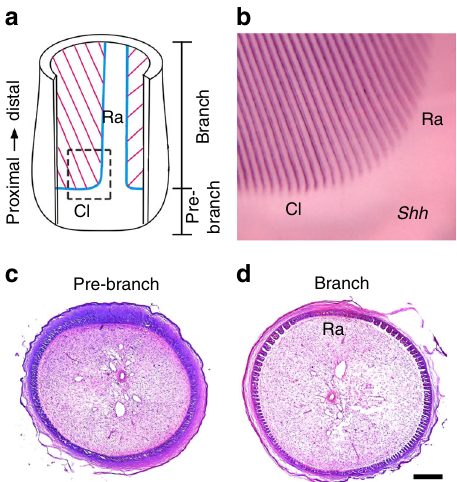
Fig. 1 Feather branching morphogenesis. a A schematic diagram showing the developing feather follicle. The proximal follicle epithelium called the collar (Cl) is not branched. Above the collar, the feather branches along the circumference of the follicle, except in the rachis (Ra). The dashed box is enlarged in b . b Feather branching is marked by Shh in situ hybridization. c , d Cross sections of the developing feather follicle in the lower collar level (pre-branch) and the upper branched level. The rachis (Ra) region is not branched. Bar = 100 μ